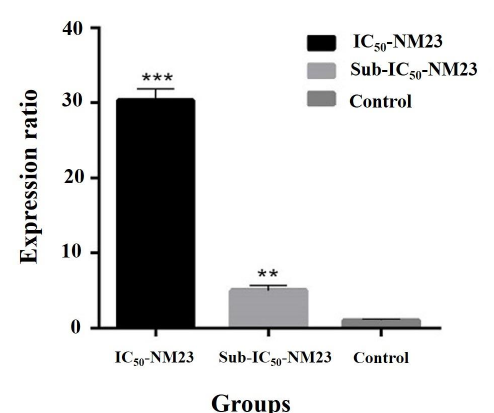
Fig. 5. NM23 gene expression in treated and untreated cells with IC50 and sub – IC50 concentrations. The reference gene (control) is β- actin (p<0.01**, p<0.01**, p<0.05*).Note: sub- IC50 represent the concentration of extract that estimate under the IC50